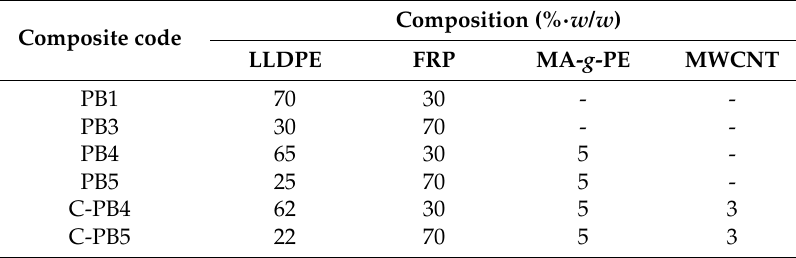
Table 1. Composition of the LLDPE–FRP